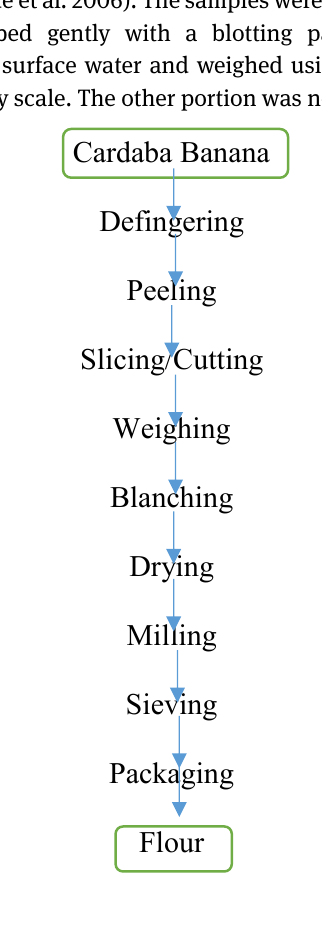
Figure 1: Flow Diagram for Cardaba Banana Flour Production (Modi- fied method of Oluwalana et al . 2011) The blanched and unblanched portions were each divided into three: the first portion was sun-dried by spreading thinly on a tray and placed under the sun to dry for 3 days (average temperature of 27 ± 2°C); the second portion was oven dried (UNISCOPE SM9053, England) at 50°C; and the third portion was oven dried (UNISCOPE SM9053, England) at 70°C. The dried samples were milled into flour using a hammer mill. The flour was then sieved using a mesh aperture of 500 µm diameter. The sieved